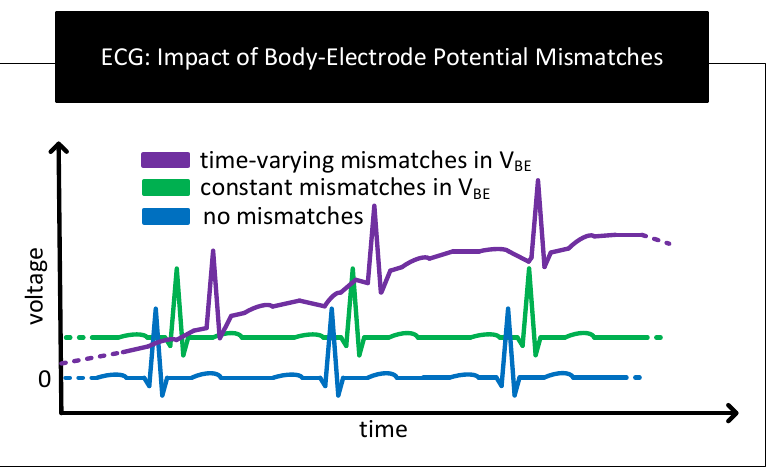
Figure 14. Representative ECG graphs in the absence and presence of mismatches in contact poten- tials. In the presence of time-varying mismatches, the baseline of the ECG graph wanders over